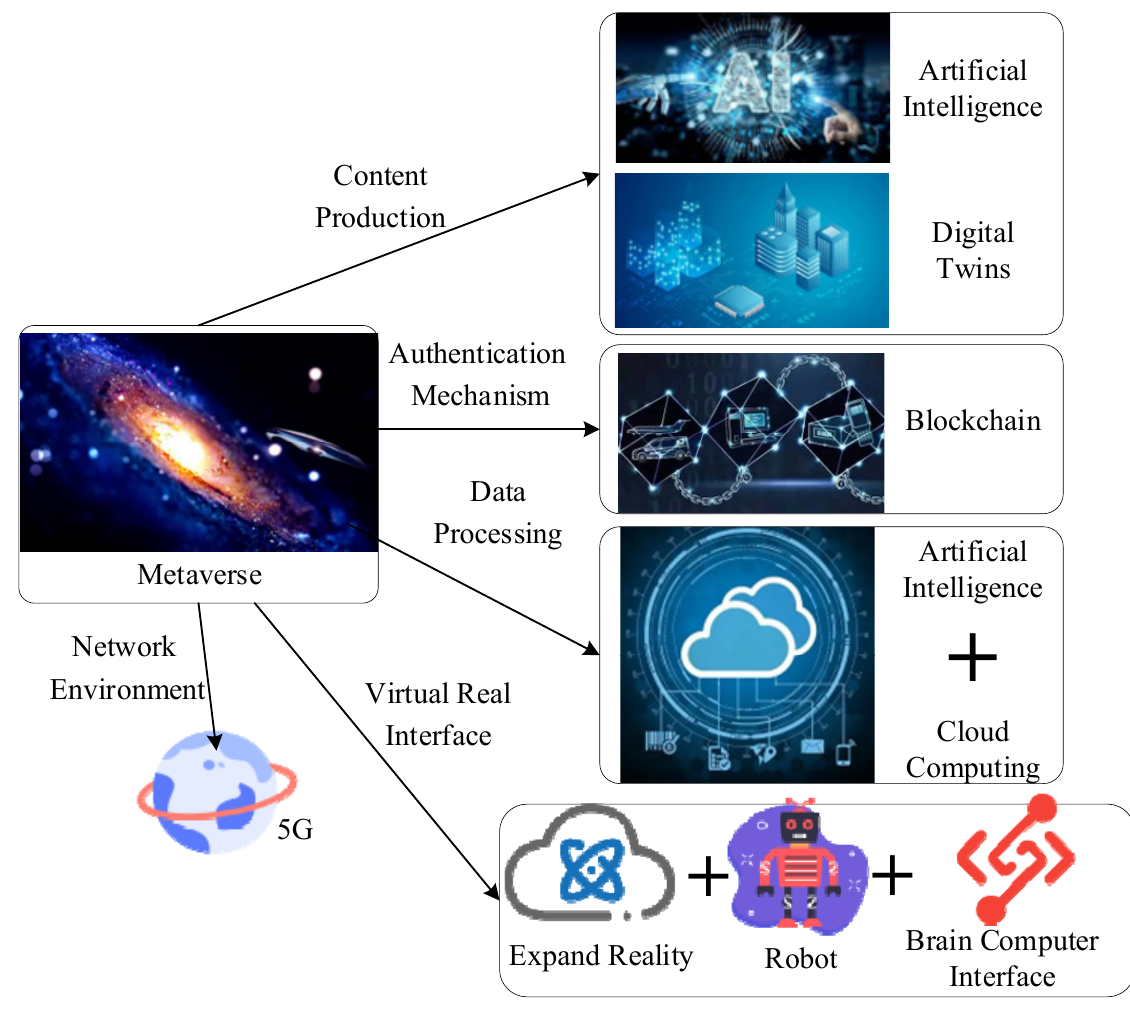
Figure 3. The technical support of the